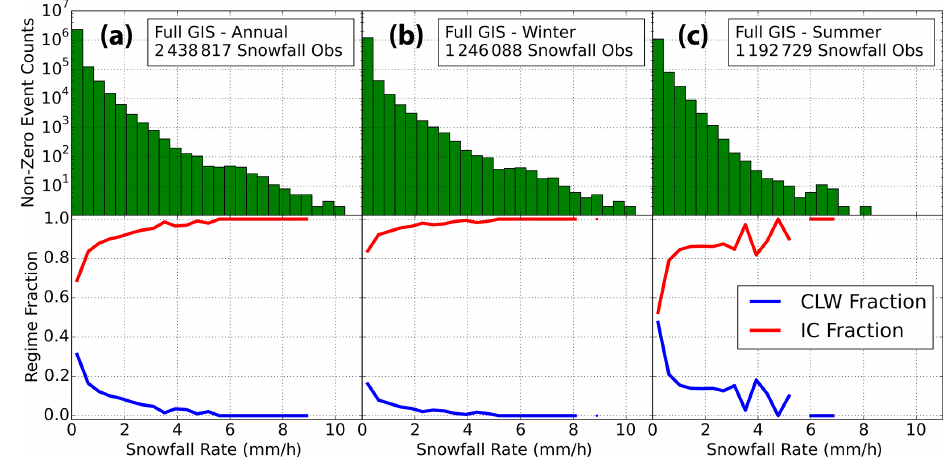
Figure 6. Snowfall rates for all observed snowfall. The top of panel (a) is a histogram of the observed rates of all GrIS snowfall from 2CSP (log scale), and the bottom of panel (a) is the regime percent for each histogram bin. Panels (b) and (c) are the same for GrIS winter (October–April) and summer (May–September) months, respectively.